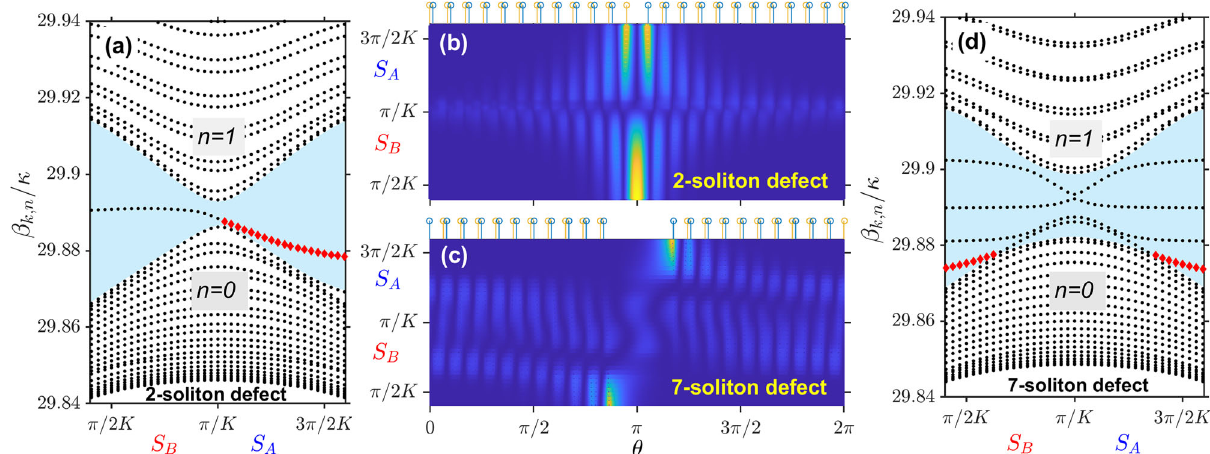
Fig. 4 Phonon edge states in soliton metacrystals with defects. a The phonon spectrum in and around the n = 0, 1 bandgap in the metacrystal with the defect made by removing one unit cell, i.e., 2-soliton defect. b The eigenfunctions of the bandgap states, j u ð α Þ k ; n j 2 , vs S α and θ . The stems along top axes mark locations of the individual solitons in a crystal with defect for S A = 3 π /2 K . c is like ( b ), and ( d ) is like ( a ), but for the 7-soliton defect created by removing (cid:6) the three unit cells plus one soliton. The red diamonds in ( a ) and ( d ) mark the spectra of the edge states. Crystals with defects are computed with 16384 E (cid:6) (cid:6) points across the resonator circumference, θ ∈ [0, 2 π ). u ð α Þ k ; n is computed using Eq. 5 with k = 0, K = 1, which corresponds to θ ∈ [0, 2 π ), see Methods for details.